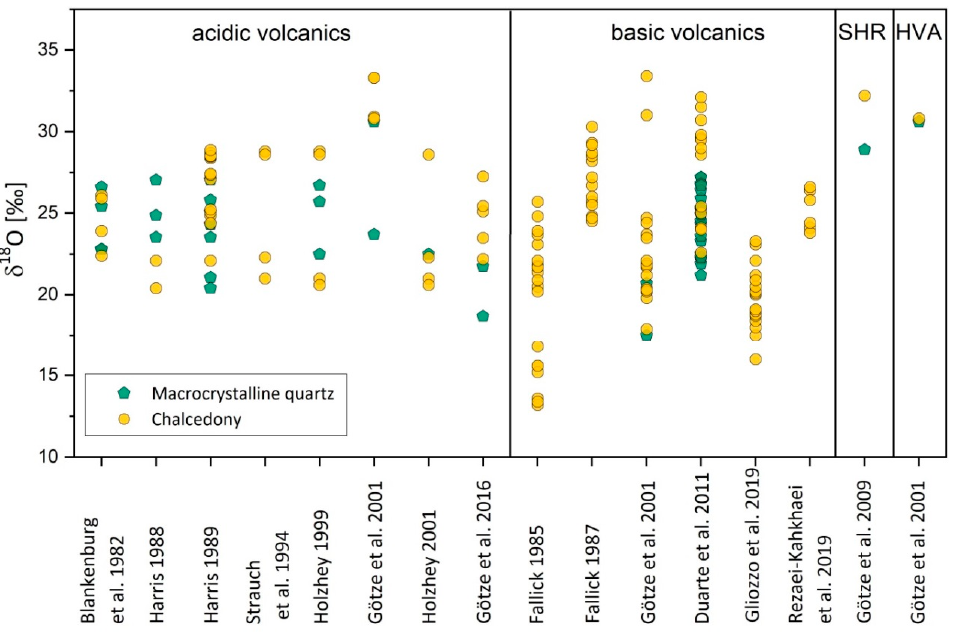
Figure 18. Compilation of oxygen isotope data ( δ 18 O) of agates from different origins (SHR = sedimentary host rock; HVA = hydrothermal vein agate); data are compiled from [14,30,31,37,58,101,140–147].